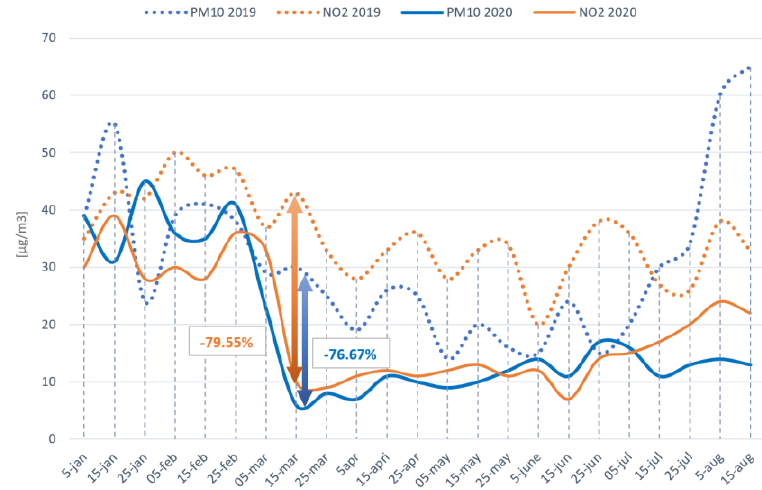
Figure 10. Chart of air pollutants in Madrid (measuring station of F. Ladreda) from January to August of 2019 and 2020. Source: Own elaboration by data collected from AQICN ([18].